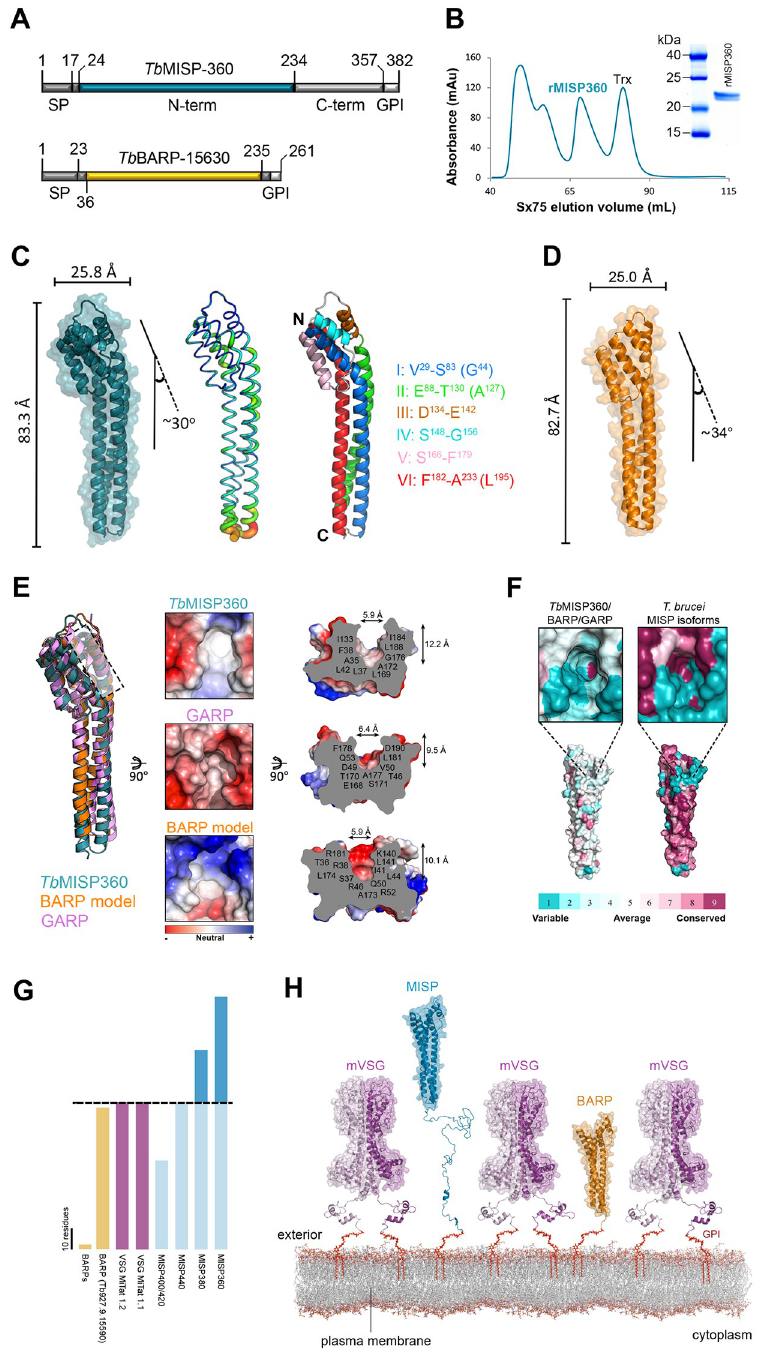
Fig 3. Crystal structures of MISP and BARP N-terminal ectodomains. ( A ) Schematic representation of MISP360 and BARP protein sequences, highlighting in color the region recombinantly expressed in E . coli and crystallized; numbers indicate residue positions, signal peptide (SP), C-terminal domain (C-term), GPI-anchor peptide (GPI). ( B ) FPLC SEC elution chromatogram of recombinant MISP360; SDS-PAGE of monomeric recombinant MISP360 (inset). ( C ) MISP360 N-terminus crystal structure with molecular surface representation. The structure was found to be 83.3 Å tall, 25.5 Å in width with a 30˚ helix bend at the top (left); B -factor putty model with ordered regions displayed in blue and thin tubes and flexible regions in red and thicker tubes (middle); secondary structure depiction highlighting the organization of the helices (right); bend-forming residues are in parentheses; coiled structures are represented in white. (D) BARP high confidence homology model generated with Modeller 9v18 [43] shown with a semi-transparent